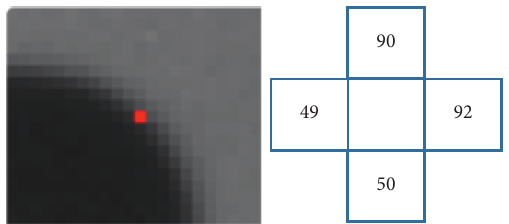
Figure 3: Calculating blocks of gradient